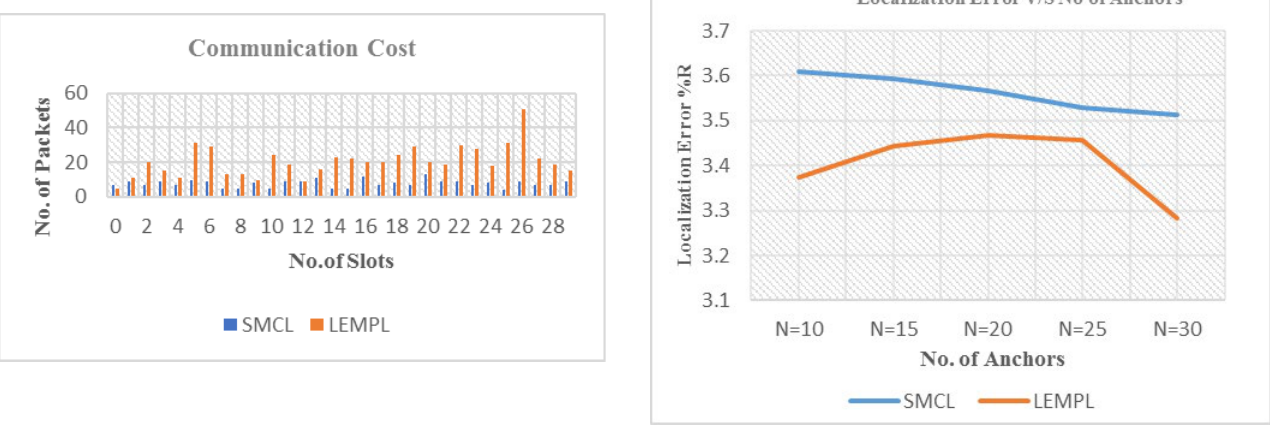
Figure 5. Effect of Increase in Anchor density over Localization